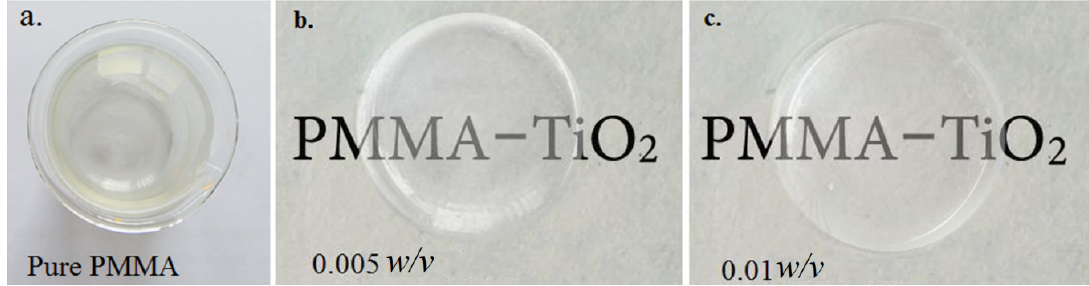
Figure 1. Photographs of synthesized samples. Legend: PMMA, poly(methyl methacrylate).